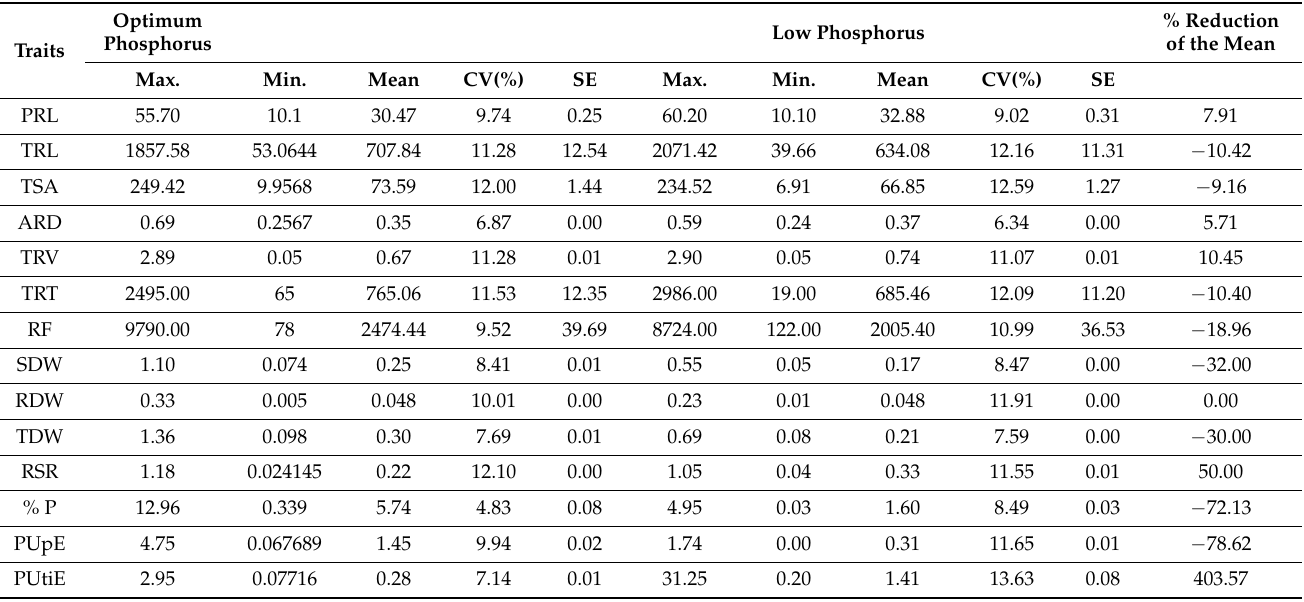
Table 1. Descriptive statistics of the measured traits in Vigna genotypes under optimum- and low-phosphorus